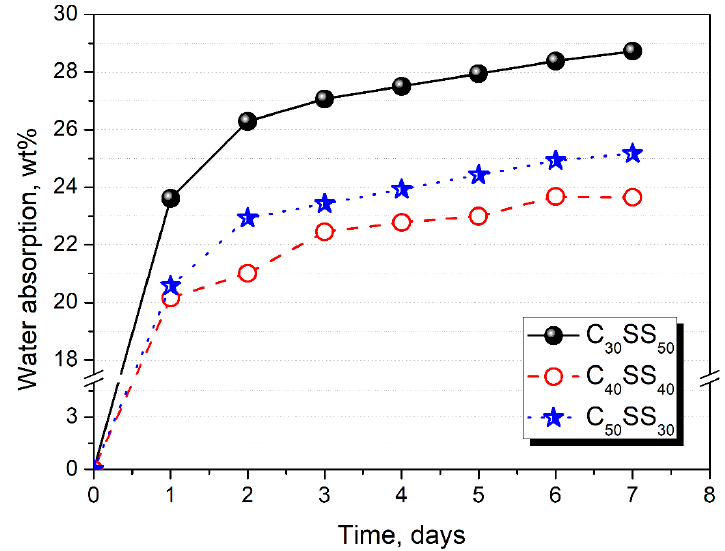
Figure 7. Water absorption of LWAs prepared in a 500 L mixer.